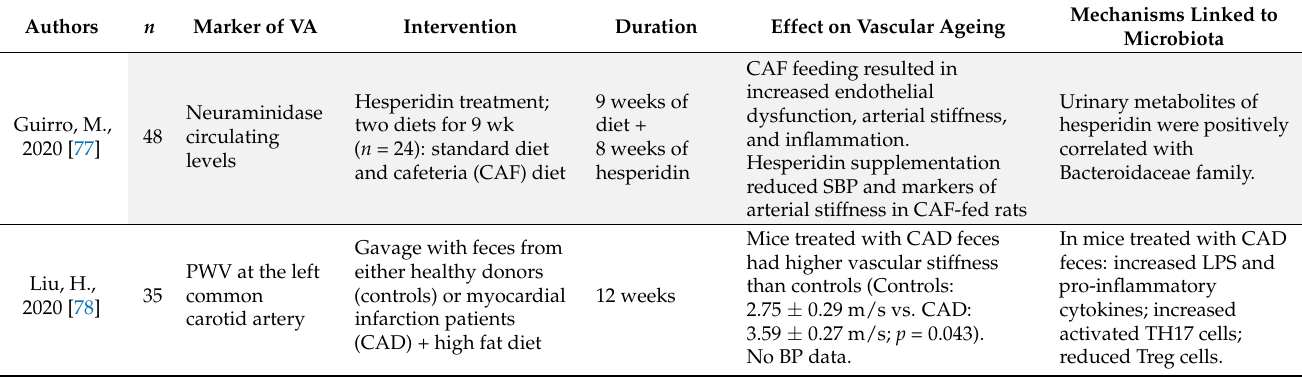
Table 1. Characteristics of animal